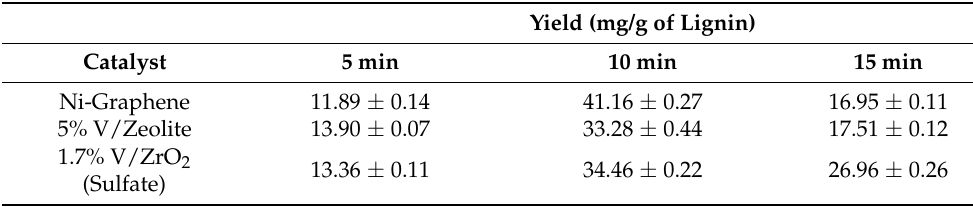
Table 3. Total Yield of phenolic monomers from the alkali lignin at 240 ◦ C for 5, 10-, and 15-min reaction time.